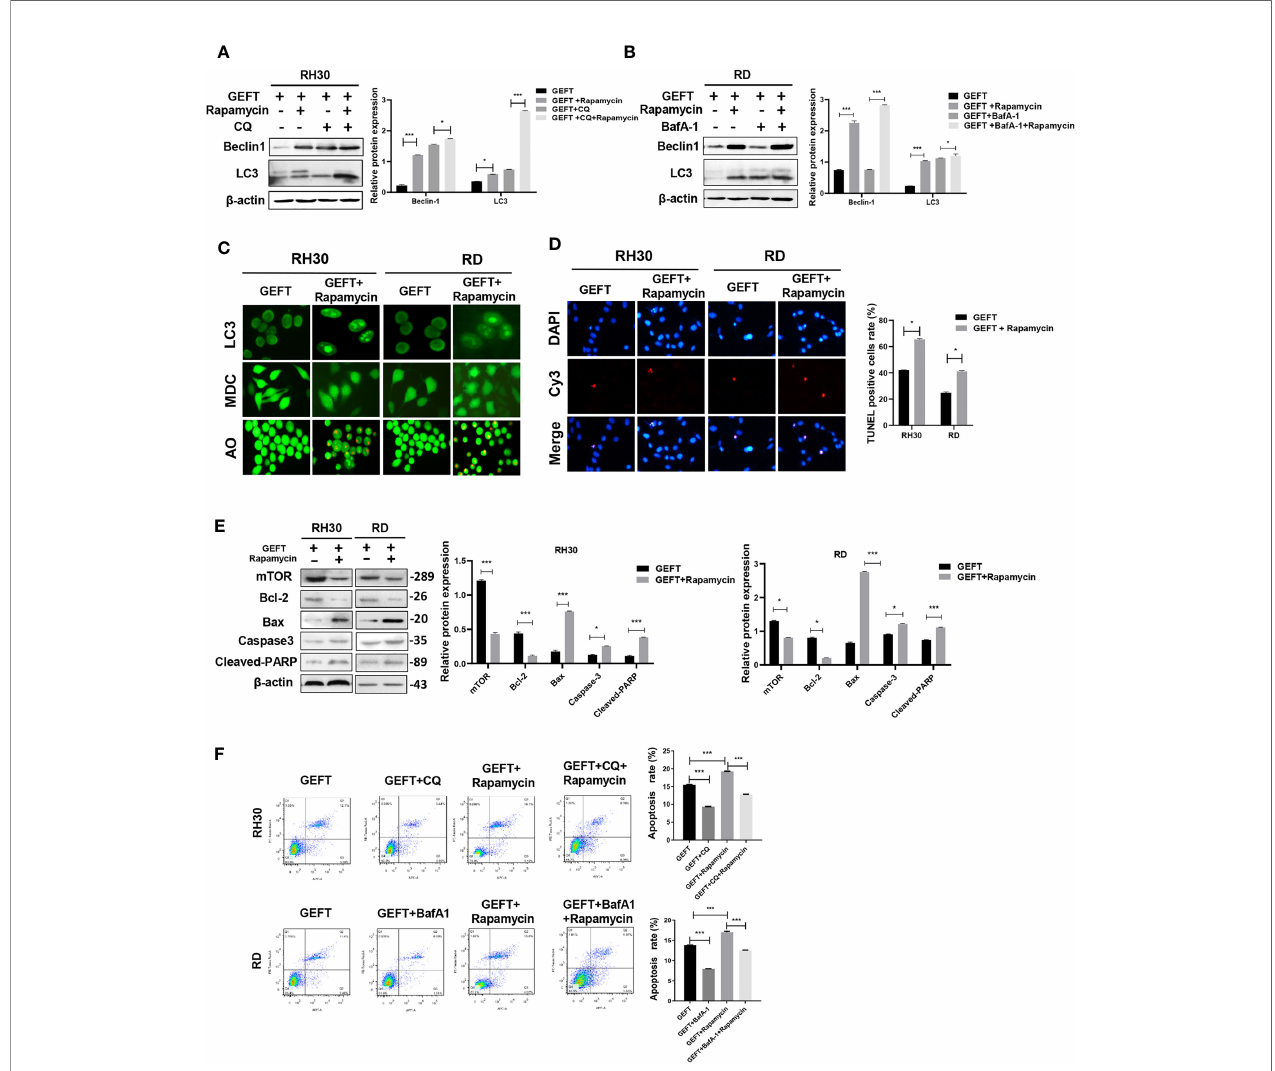
FIGURE 6 | Inhibiting mTOR-promoting autophagy and apoptosis in RMS cells of overexpressing GEFT. (A) Western blotting was used to detect the expression of Beclin1 and LC3 protein in RH30 cells transfected with GEFT, GEFT+Rapamycin, GEFT+CQ, and GEFT+CQ+ Rapamycin. (B) Western blotting was used to detect the expression of Beclin1 and LC3 protein in RD cells transfected with GEFT, GEFT+Rapamycin, GEFT+BafA-1, and GEFT+BafA-1+Rapamycin. (C) The representative images of RH30 and RD cells transfected with GEFT and GEFT+Rapamycin were detected by immuno fl uorescence, MDC and AO staining. (D) The apoptosis of RH30 and RD cells transfected with GEFT and GEFT+Rapamycin was detected by TUNEL. (E) Western blotting was used to detect the expression of mTOR, Bax, Bcl-2, Caspase-3, and Cleaved-PARP protein in RH30 and RD cells transfected with GEFT and GEFT+ Rapamycin. (F) Flow cytometry was used to detect the apoptosis of RH30 cells and GEFT- transfected RH30 cells in GEFT, GEFT+CQ, GEFT+ Rapamycin and GEFT+ Rapamycin +CQ groups. Flow cytometry was used to detect the apoptosis of RD cells and GEFT-transfected RD cells in GEFT, GEFT+BafA-1, GEFT+Rapamycin and GEFT+ Rapamycin+BafA-1 groups. *** P < 0.001, * P <